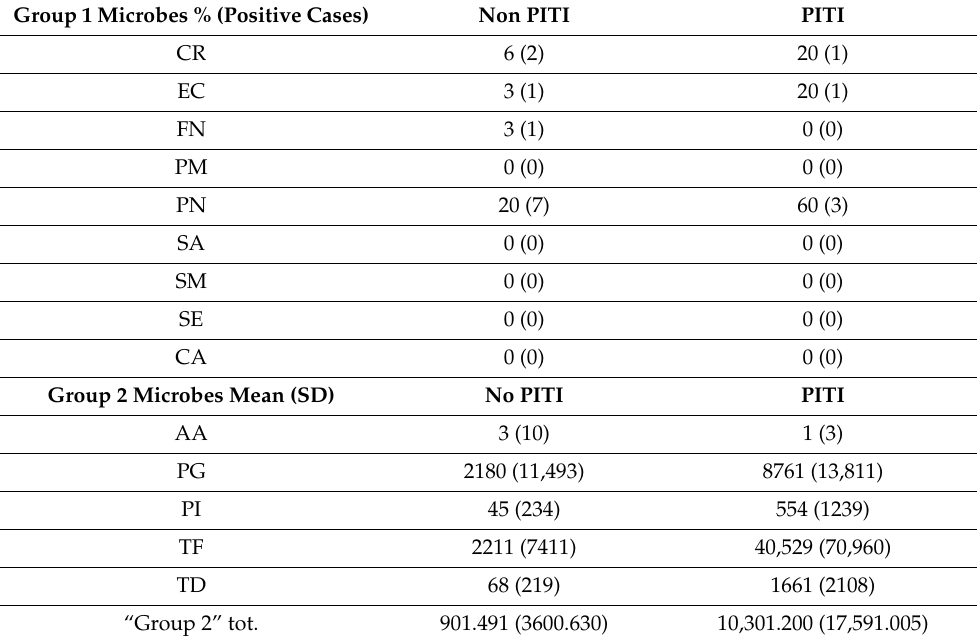
Table 6. Qualitative and quantitative assessment of the microbial species in the implants with or without PITI in the CBP group (40 patients; 40 implants): percentage of positive cases (“Group 1”); mean (SD) (“Group